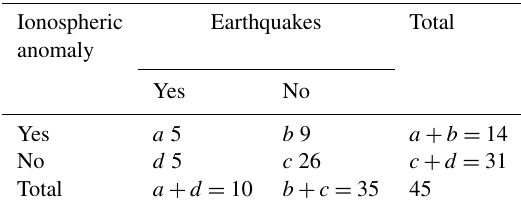
Table 5. Confusion matrix. Ionospheric